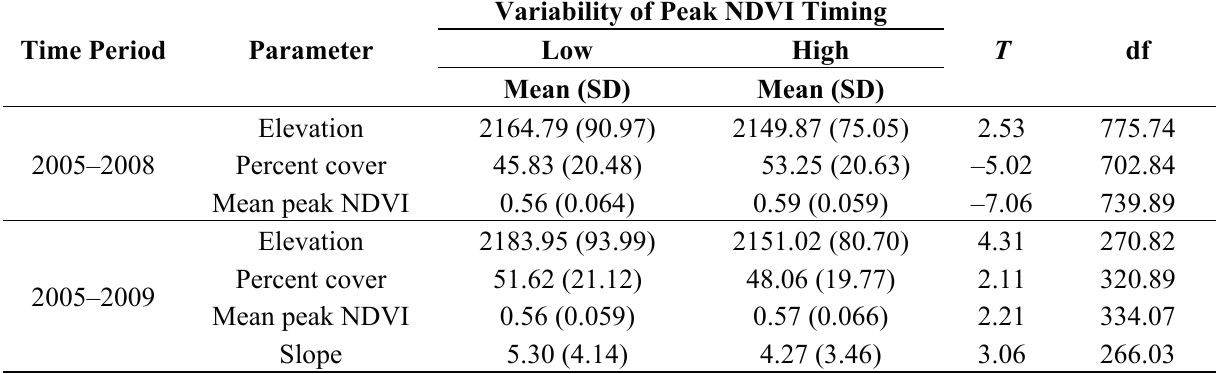
Table 4. Results of Welch’s t -test of variables in pixels displaying low or high variability of peak NDVI timing from 2005–2008 and 2005–2009 for 800 random point locations across the ponderosa pine ecosystem. Only parameters significant at p < 0.05 are shown. SD = standard deviation.